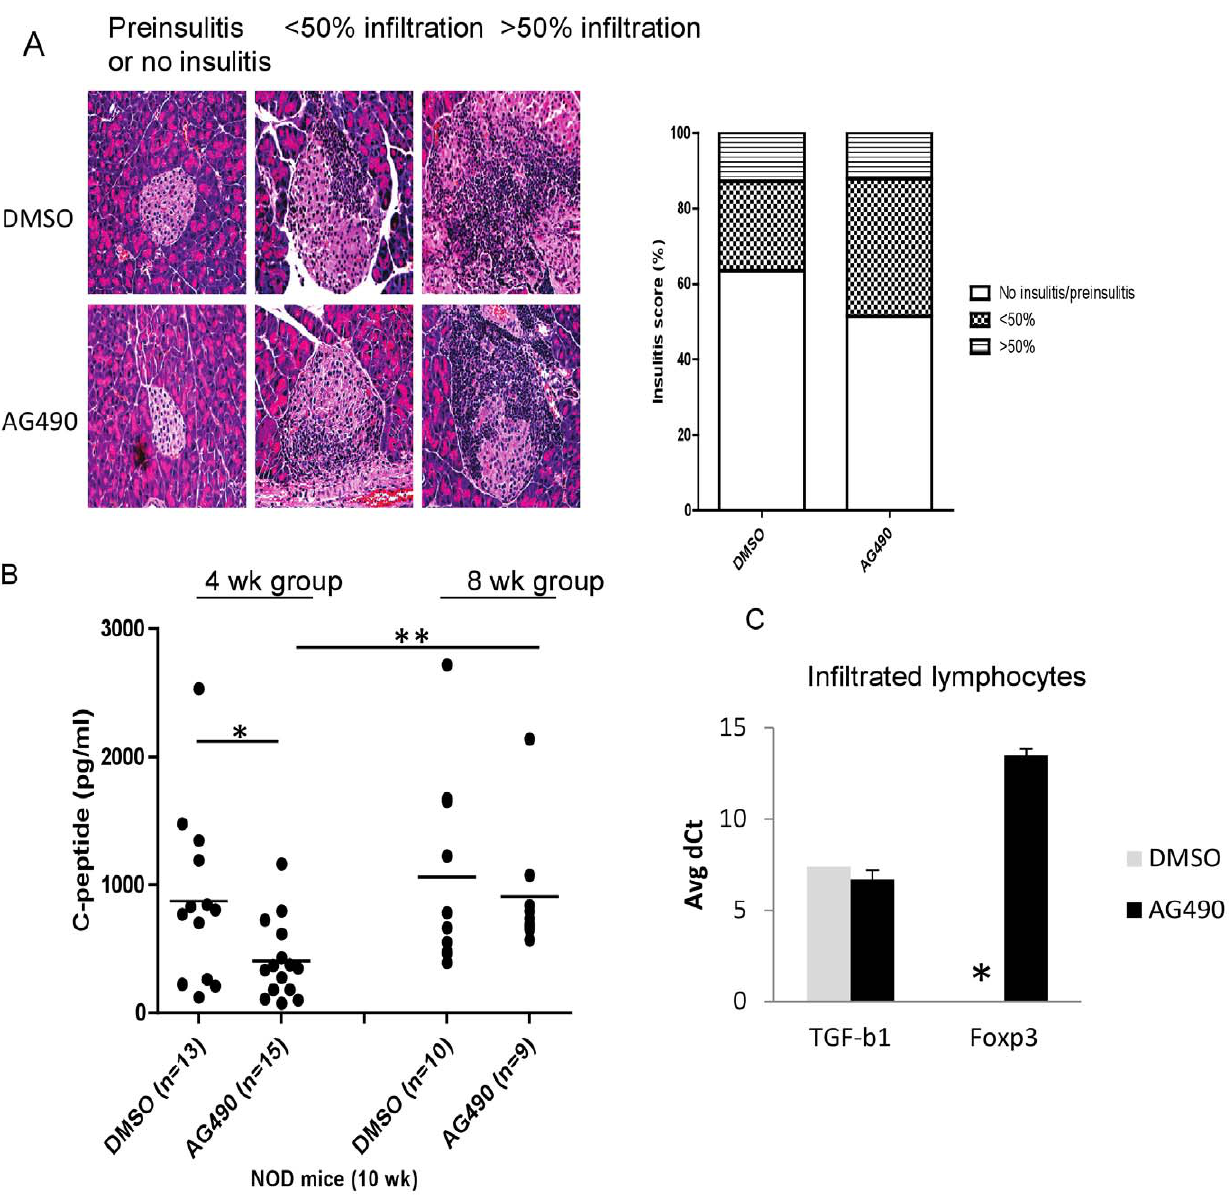
Figure 4. AG490 does not block infiltration of leukocytes in the islets. A- Prediabetic NOD mice at 4 weeks of age were treated with AG490 or DMSO (n=5 per group) for 5 consecutive weeks (3 6 per week) and mice were sacrificed one week after the last injection at week 10. Insulitis was scored by two different investigators and an average of two different scores is shown (p=n.s). At least 150 islets per group in two interrupted sections, 100 m m apart, was scored. B- The C-peptide level was measured as described in materials and methods and no significant differences were found. C- Five prediabetic NOD mice at 4- weeks of age were treated with AG490 or DMSO (n=5 per group) as described above for 5 consecutive weeks and then sacrificed at week 10, C- real-time RT-PCR was performed on enriched infiltrated lymphocyte from the pancreas of 5 mice/group and expression level of Foxp3 and TGF- b 1 was measured in three independent RT-PCR by TaqMan Gene expression (Life Technologies, Applied Biosystems, Assays-on-Demand) (*=expression was very low and/or undetectable). [Figure 4A is intended to be in color online and black and white in print.]